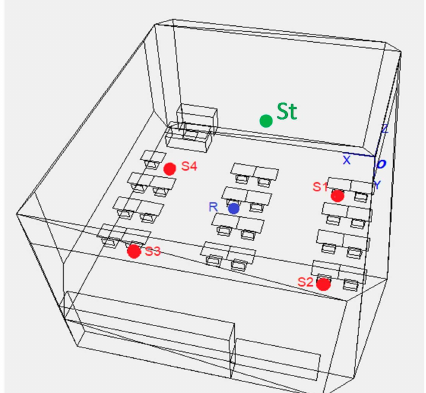
Figure 2. Virtual classroom with the positions of the talker (S t ), receiver (R), and the two (S1 and S3) and four (S1–S4) competing